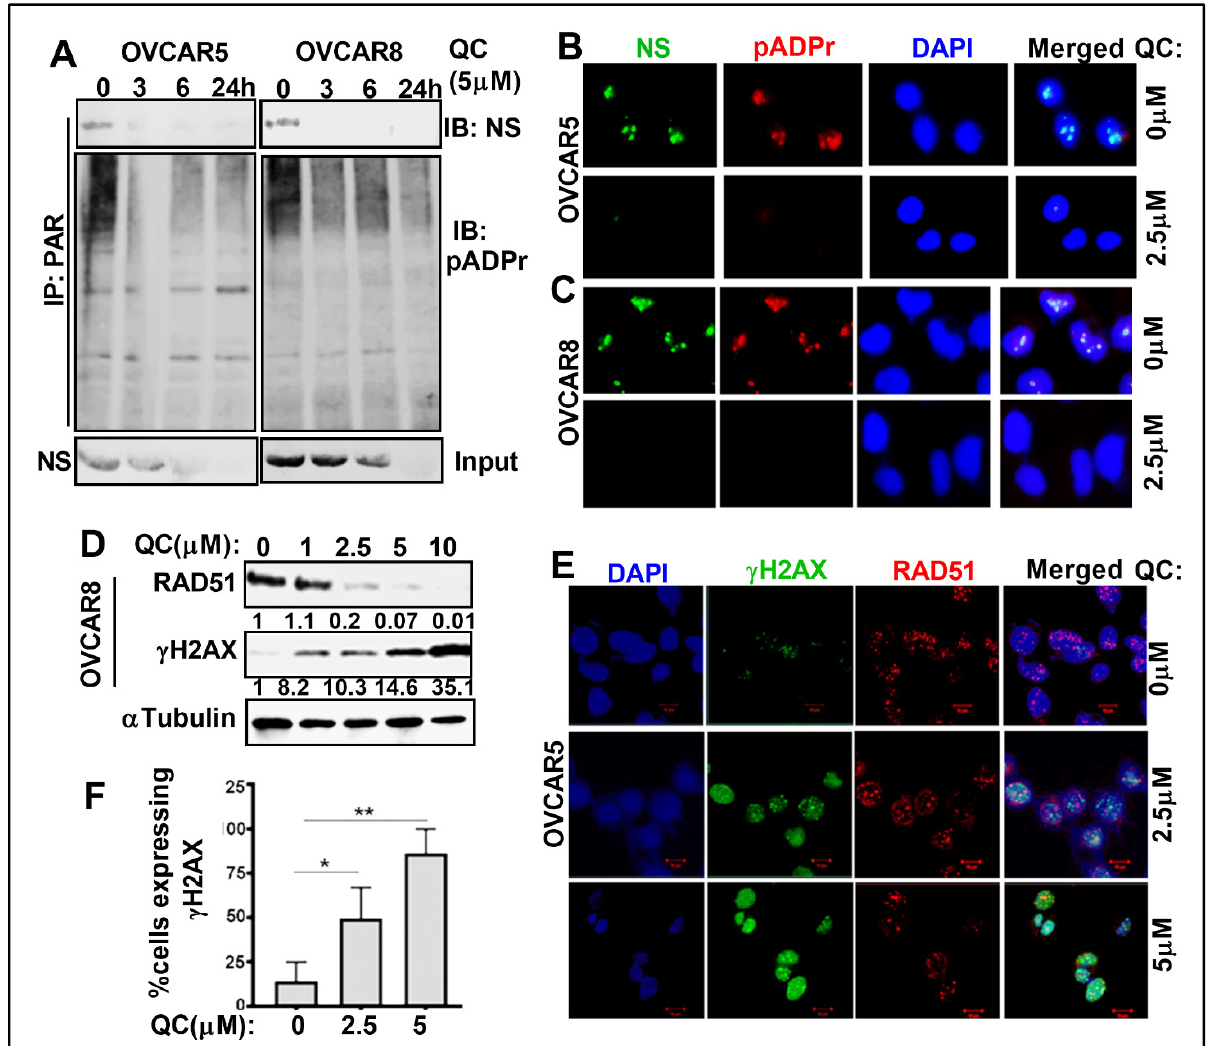
Figure 5. QC downregulates NS PARylation. and induces DNA damage. ( A ) OVCAR5 and 8 cell extracts were immuno- precipitated with anti-PAR antibody from untreated and QC-treated cells and probed for NS PARylation levels in a time dependent manner. ( B ) IF analysis shows NS (green) and pADPr (Red) colocalizes with each other (Merged image) and DAPI was used to stain the nuclei in OVCAR5 and ( C ) OVCAR8 cells. ( D ) Western analysis was performed in OVCAR8 cells to show the dose dependent increase in γ H2AX levels and concomitant reduction in RAD51 levels upon QC treatment. α Tubulin was used aa loading control. Densitometric analysis was performed using Image J, normalized and fold change was provided beneath the panel. ( E ) Representative IFC images of OVCAR5 cells untreated and treated with 2.5 and 5.0 µ M QC showing γ H2AX (green) and RAD51 (Red). DAPI-stained nuclei are in blue. ( F ) Quantitation of γ H2AX levels. The number of cell nuclei displaying <5 foci (negative), between 6 and >20 foci, and diffuse pan-nuclear staining for pH2AX and RAD51 foci was quantified. At least 50 cells were counted ( × 40) for drug treatment per experiment. * ( p < 0.05), ** ( p <